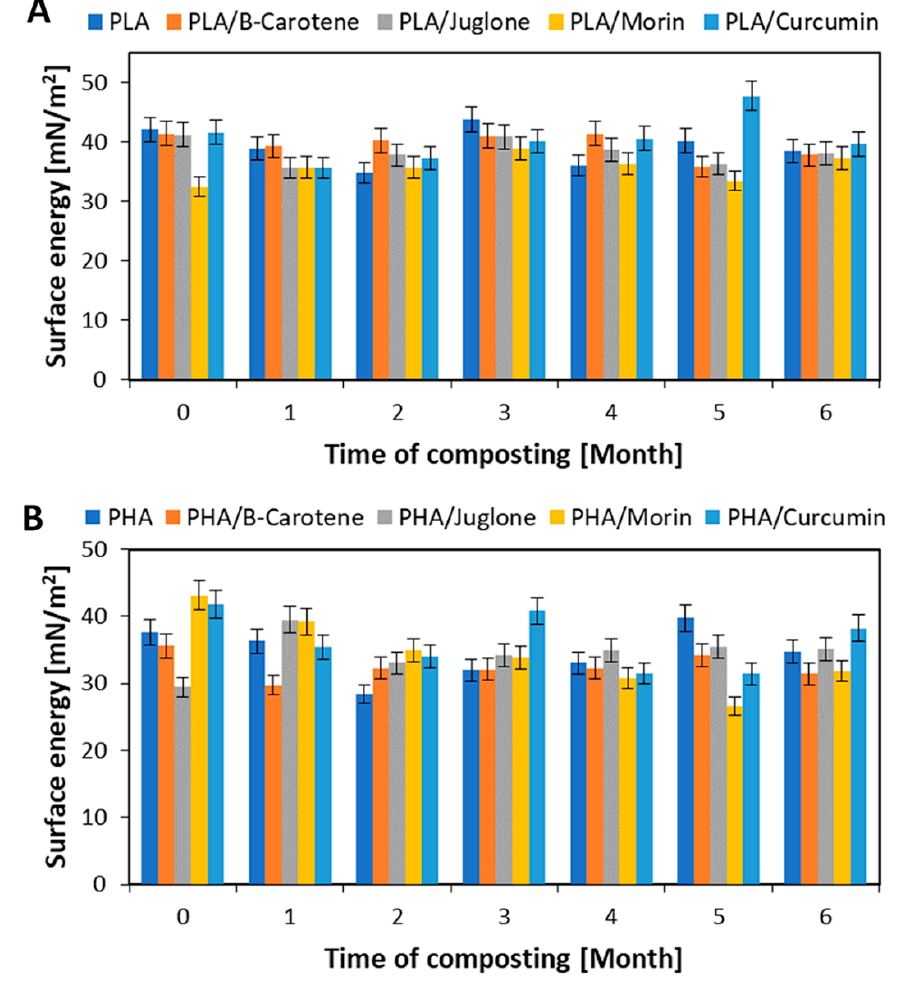
Figure 5. Changes in surface energy of PLA ( A ) and PHA ( B ) samples during composting. Table 1. Contact angle obtained using water, diiodomethane, and ethylene glycol for PLA samples during 6 months of composting.